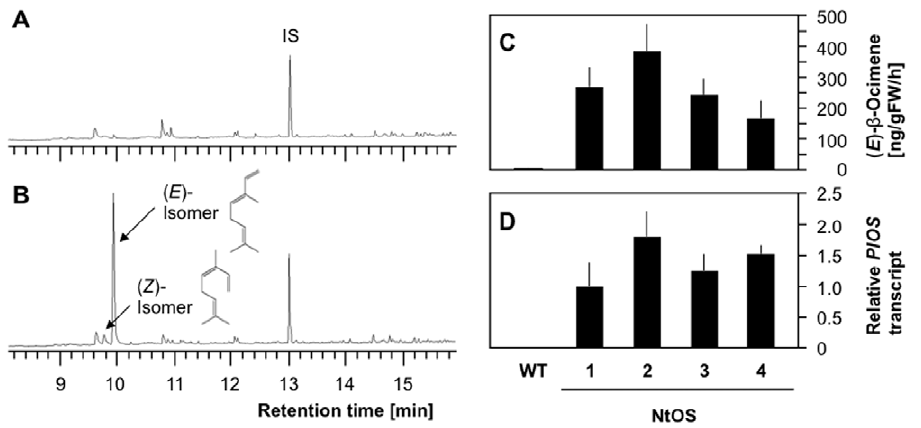
Figure 1. Emission of b -ocimene from PlOS -transgenic plants. Representative gas chromatography-mass spectrometry profile of volatiles emitted from the wild-type ( A ) and transgenic ( B ) tobacco plants are presented. Values for ( E )- b -ocimene emission ( C ) and relative PlOS transcript ( D ) in transgenic plants represent the means + standard errors (n=4–5).